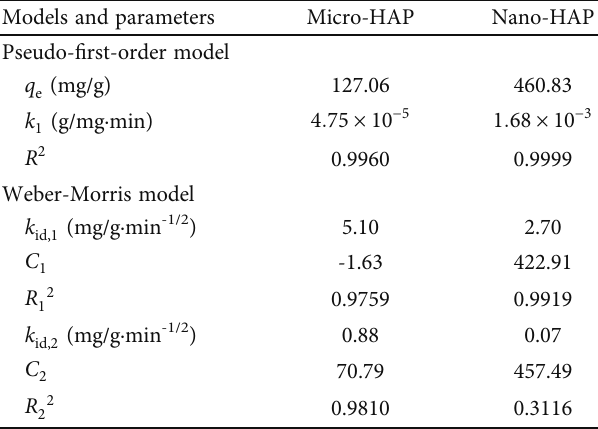
Figure 3: The kinetics of Ni(II) sorption on (a) micro-HAP and (b) nano-HAP (the solid lines: fi tting plots of the Weber-Morris model). Bottom right fi gures: the fi tting plots of the pseudo-second-order equation. ( T = 298 ± 1 K , I = 0 : 1 mol/L NaClO mg/L, and pH = 6 : 7 ± 0 : 1 ). Table 1: The parameters of pseudo- fi rst-order and Weber-Morris models of Ni(II) adsorption on micro-HAP and nano-HAP. Models and parameters Micro-HAP